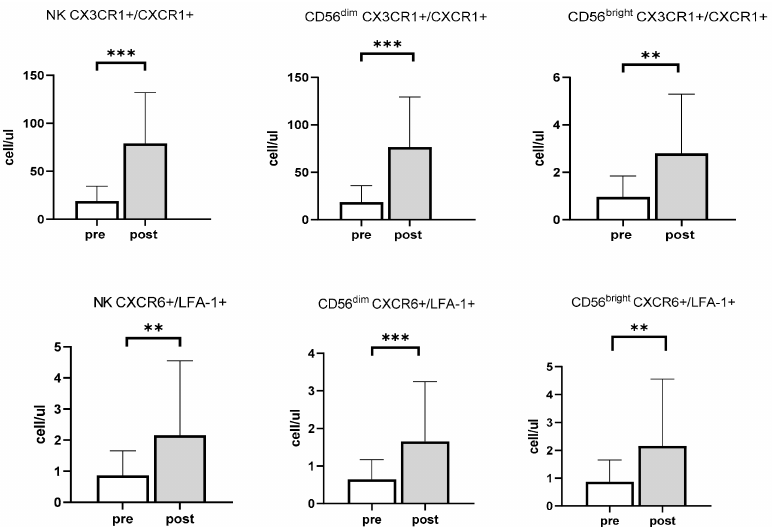
Figure 1. The effects of acute exercise on the mobilization of total NK cells, CD56 dim cells and CD56 bright cells expressing CX3CR1+/CXCR1+ and CCR6+/LFA-1+ in healthy young adults ( n = 22). Pre-exercise values are represented in white, whereas post-exercise values are represented in light gray. ** Significant differences between pre- and post-exercise, p < 0.01. *** Significant differences between pre- and post-exercise p < 0.001. Data are mean ±